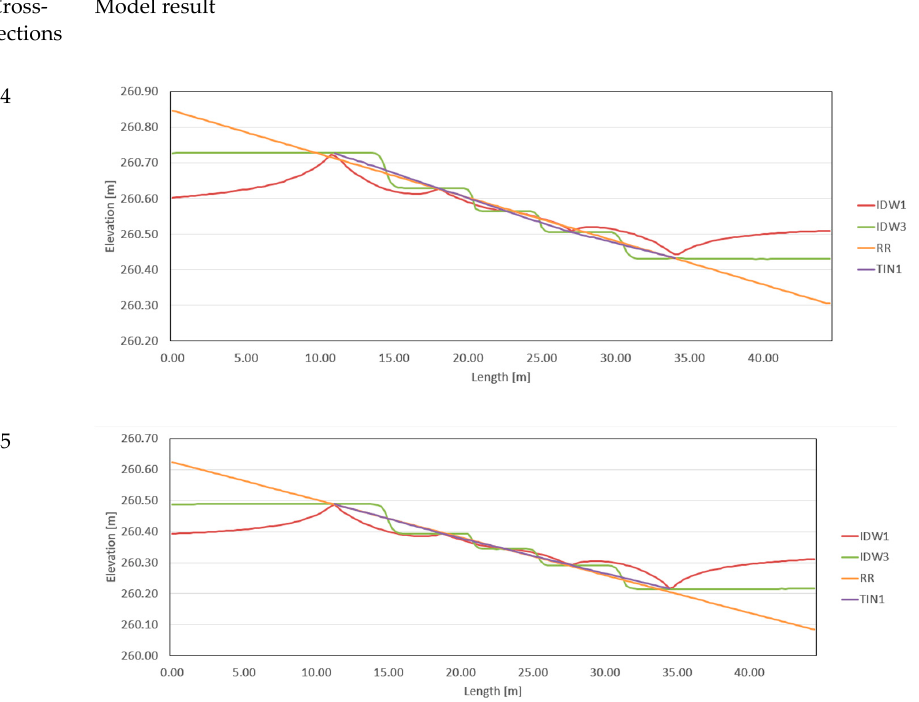
Figure 9. Runway modelling in cross section P4 and P5 by selected models.